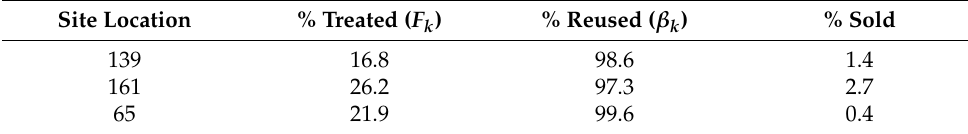
Table 9. Optimal fraction for treatment of wastewater for reuse: IIT Madras network.